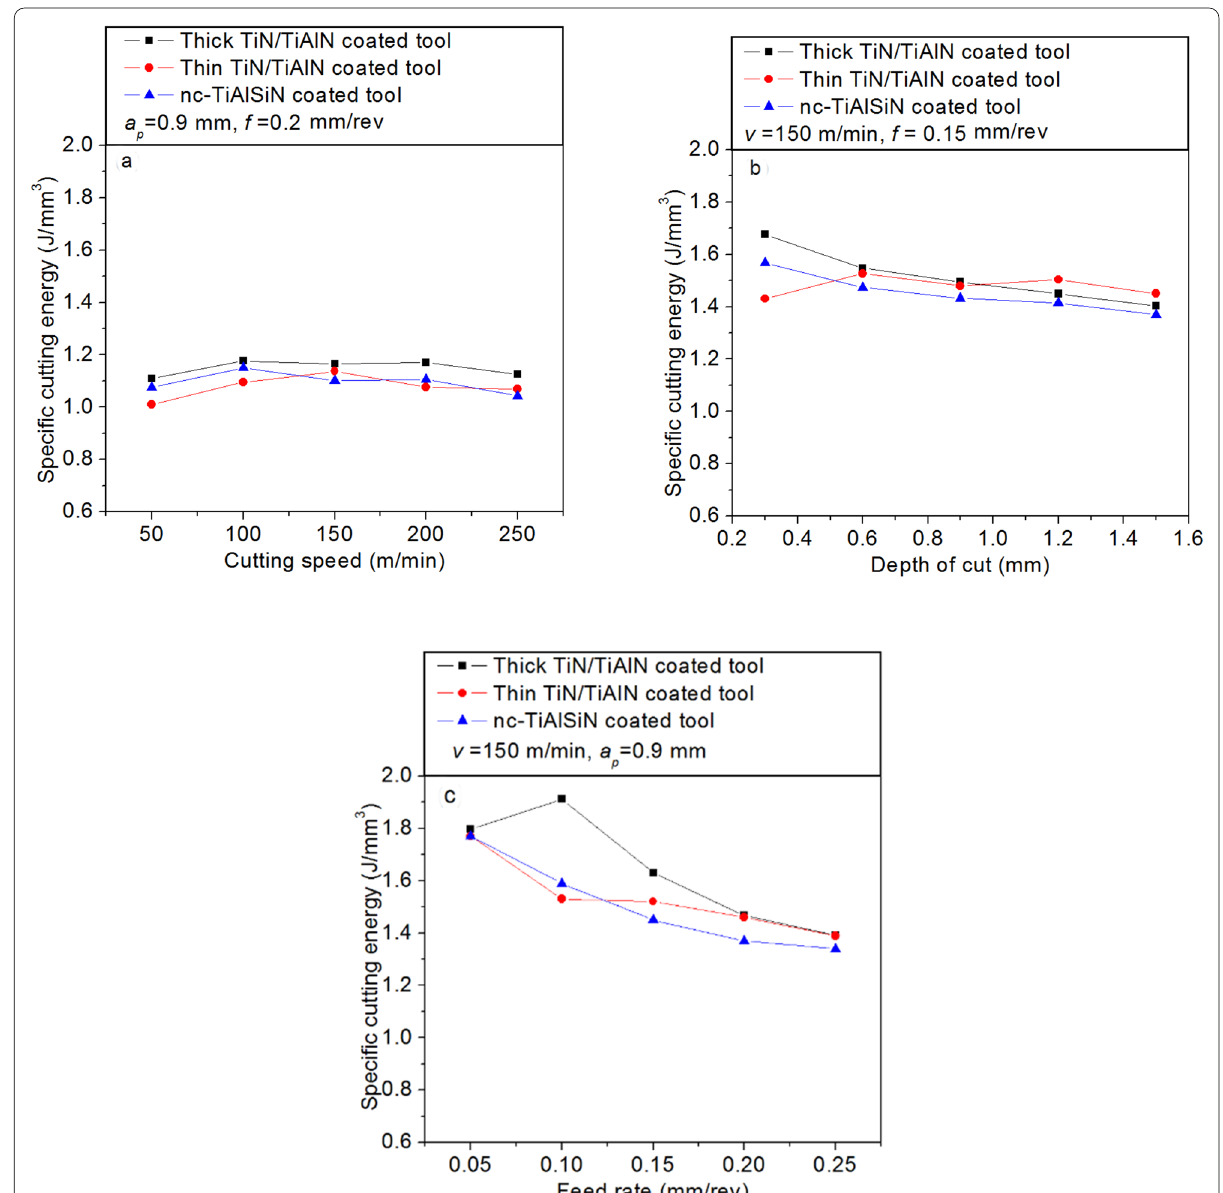
Figure 4 Specific cutting energy of the three coated tools under various cutting conditions in dry turning of MCI: a a p v 150 m/min, f 0.15 mm/rev; and c v = =